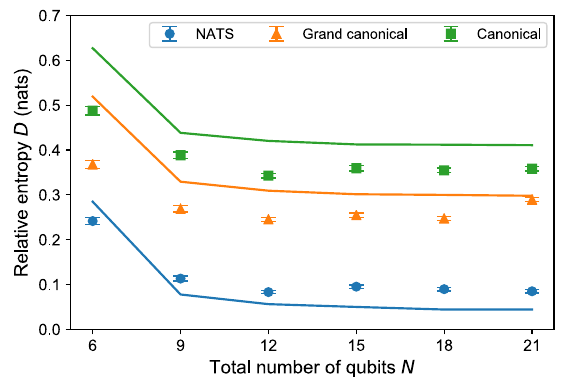
FIG. 3. The average distance from the long-time system-of- interest state to the thermal prediction versus total number of qubits. The markers show experimental data, while the lines are calculated numerically, using unitary dynamics, from Eq. (3). The NATS predicts the final state the most accurately at all sys- tem sizes. Depolarizing noise appears to explain the experiment- theory discrepancies. The N = 6 point is an outlier due to the small size of the global